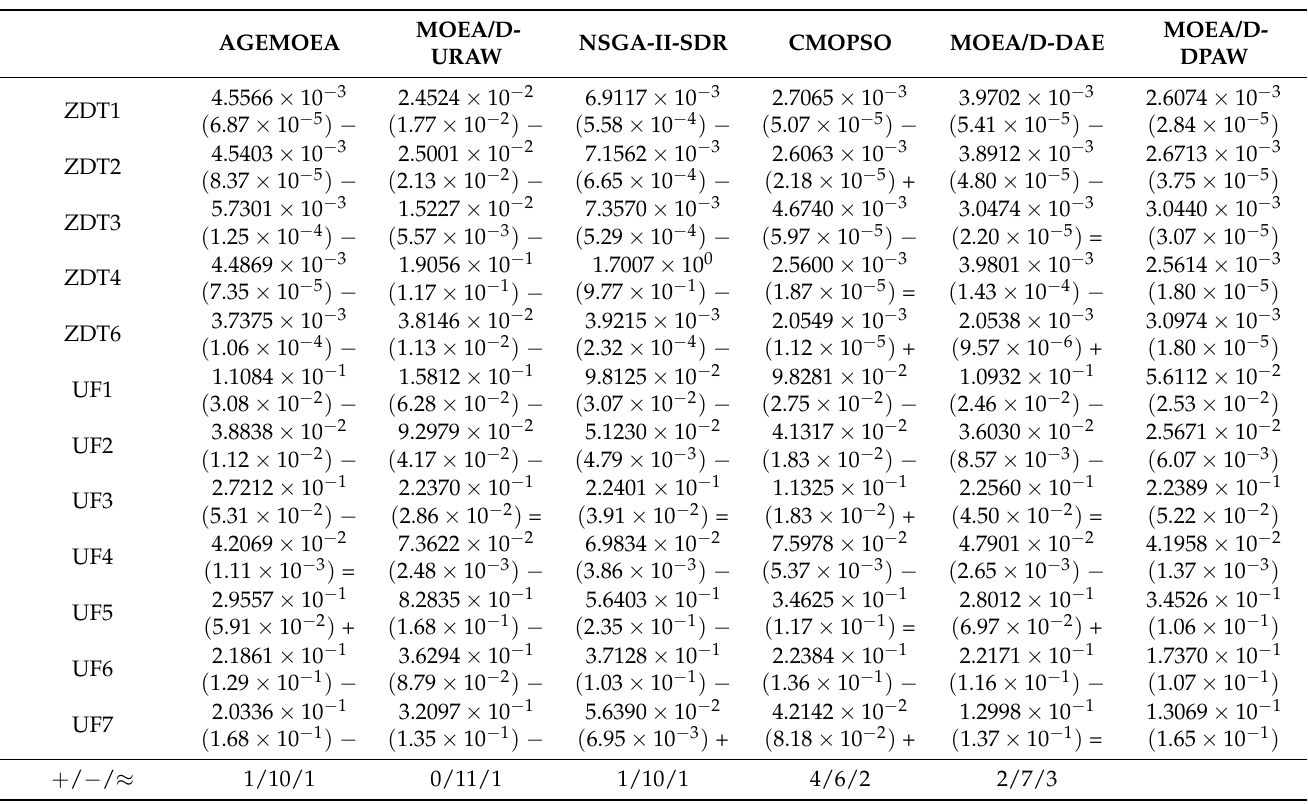
Table 1. IGD values obtained by six algorithms about two-objective optimization problems on ZDT and